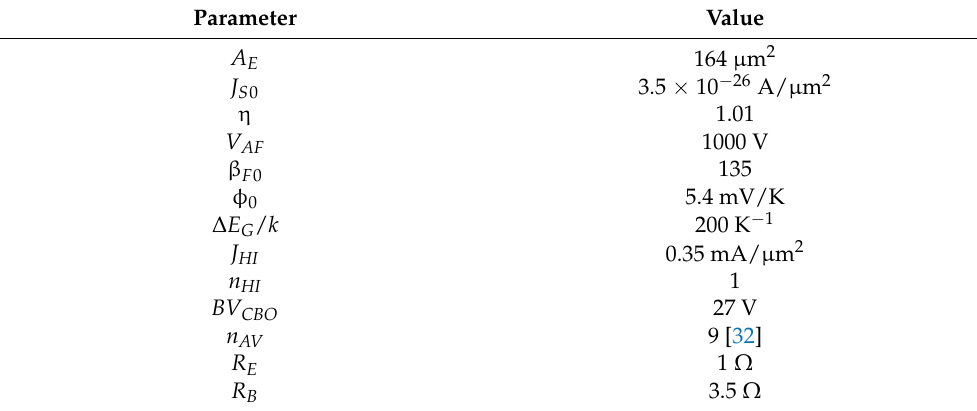
Table 2. Model parameter